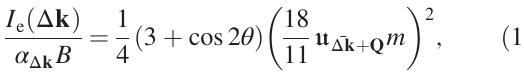
FIG. 8. Angular distribution of the elastic component of the scattered light intensity along the direction ϕ ¼ π = 4 . The calculations use the AFM-order parameter m computed with RPA corrections. Here, the number of sites is 40 × 40 and the ð Δ k Þ for different values of m , when lattice depth s ¼ 25 . (a) I e both species are detected. Different curves represent U ¼ 7 . 3 J ¼ 0 . 3 (solid line), U ¼ 3 . 9 J and m ¼ 0 . 25 (dashed and m RPA RPA ¼ 0 . 15 (short dashed line). In line), and U ¼ 2 . 0 J and m RPA (b), we compare the results for the total density with the single- ¼ 0 . 3 ). Curves from top to bottom: species detection ( m RPA ð Δ k Þ (solid). The I ↓ e ð Δ k Þ (dashed), I ↑ e ð Δ k Þ (dash-dotted), and I ffiffiffi p e 2 magnetic Bragg peak is observable since κ ¼ 1 . 5 > . Note that the highest peak in (a) corresponds to the smallest one in